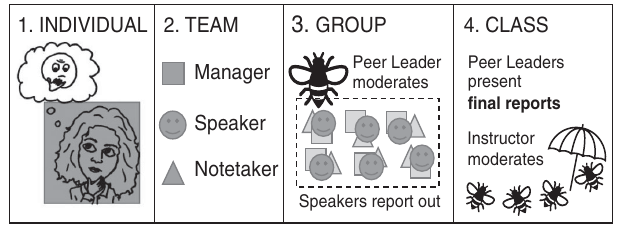
FIG. 2. The four rounds of the class discussion format. Grades are assigned for rounds 1 and 2 to the class, and for rounds 3 and 4 to Peer